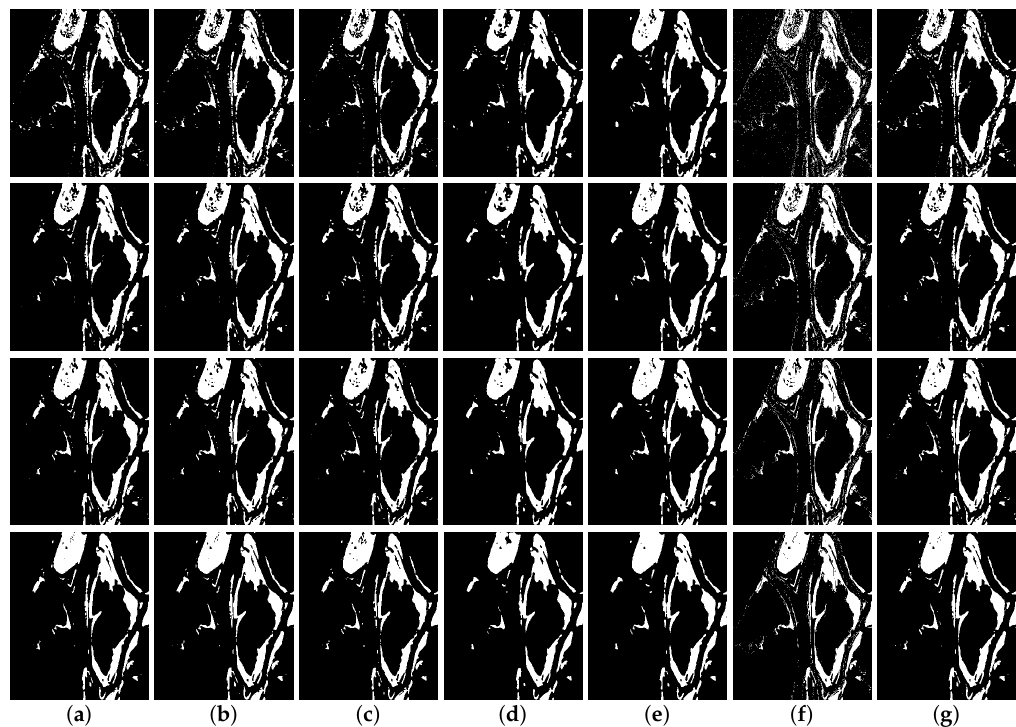
Figure 11. Results of ( a ) PCAK, ( b ) SPC, ( c ) FCM-MRF, ( d ) GTLC, ( e ) SACD, ( f ) Conradsen, and ( g ) SC-SGD on the Ottawa dataset. From top to bottom: each row contains the results of the input image, and images filtered by median, SAR-BM3D, and PPB filters,